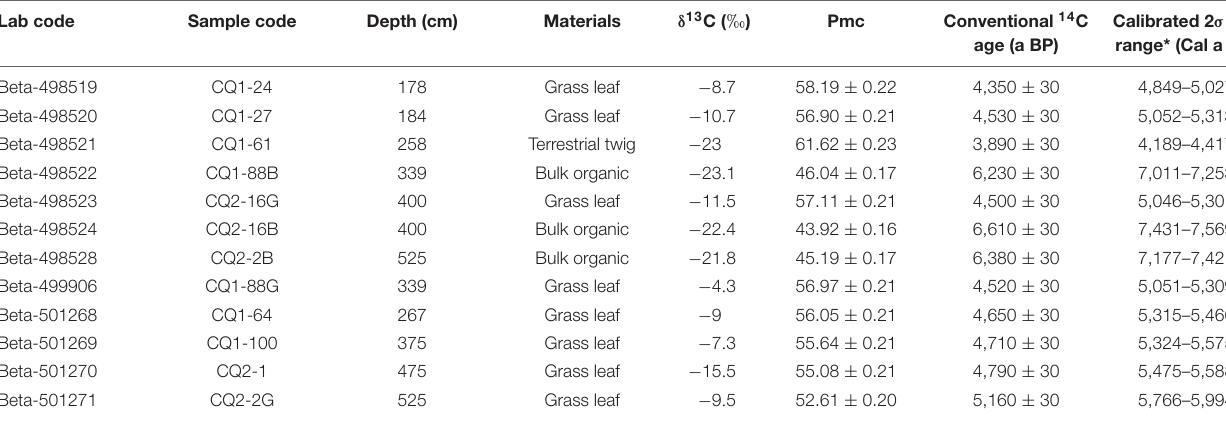
TABLE 2 | Radiocarbon dating